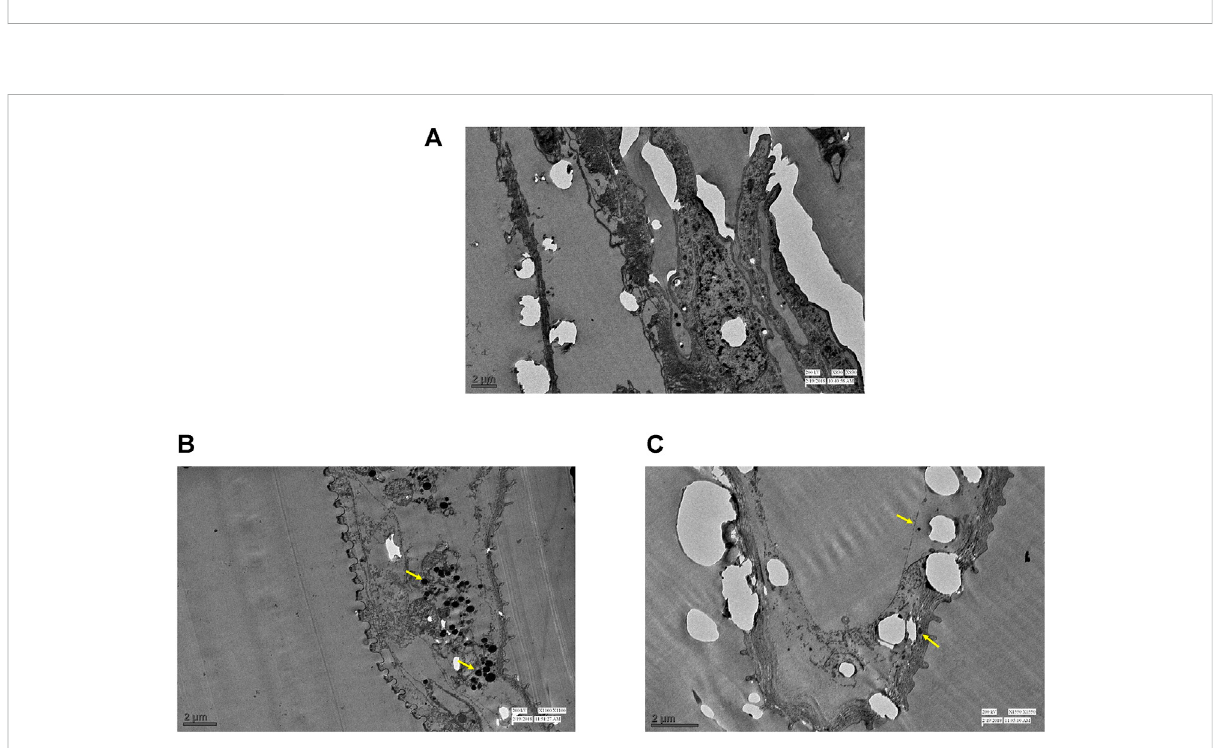
FIGURE 5 TEM images of mid-guts of early fourth instars of Aedes aegypti ; (A) control; (B) larva exposed to Achyranthes aspera leaf extract-mediated silver nanocomposites (AL-AgNCs); (C) larva exposed to Achyranthes aspera stem extract-mediated silver nanocomposites (AS-AgNCs); ( → ) indicates deposition of black